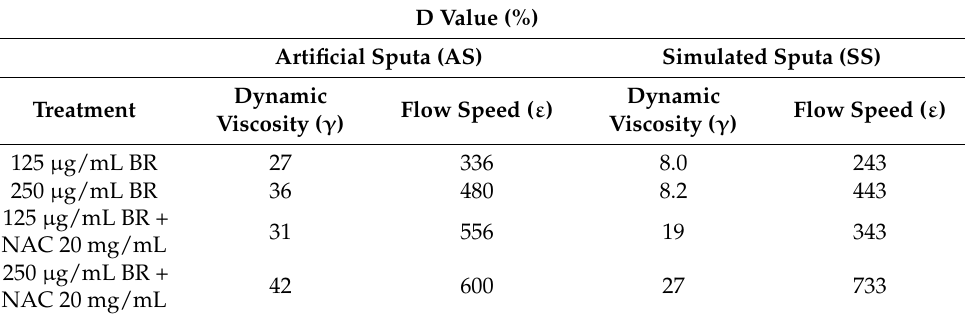
Figure 5. ( A ) The concentration of bromelain in the artificial sputa (AS) increases almost 2-fold with exposure to a two-fold increase in concentration of aerosolized bromelain (125 vs. 250 µg/mL). However, the difference was relatively small for the SS, simulated sputa, 58 vs. 62 µg/mL. ( B ) The difference between the low (10 mg/mL) and the high (20 mg/mL) NAC in the artificial sputa (AS) was relatively small (difference of 0.15 mg/mL) when exposed to aerosolized NAC. However, in the simulated sputa (SS), the difference was relatively larger (1.85 vs. 2.37 mg/mL), about a 28% increase. ( C ) Comparative levels of bromelain in artificial and simulated sputa before and after addition of 20 mg/mL NAC to the aerosolized solution. The concentration of bromelain is relatively higher in both sputa models in the presence of NAC 20 mg/mL. Table 5. The concentration of either bromelain (BR) or acetylcysteine (NAC) in two sputa models (AS and SS) after passage of nebulized solution over the sputa with just bromelain, just NAC, or Table 6. Comparison of viscosity ( γ ) and flow speed ( ε ) between the two sputa models when treated their combination, over 25 min. with bromelain 125 or 250 µ g/mL and in combination with NAC 20